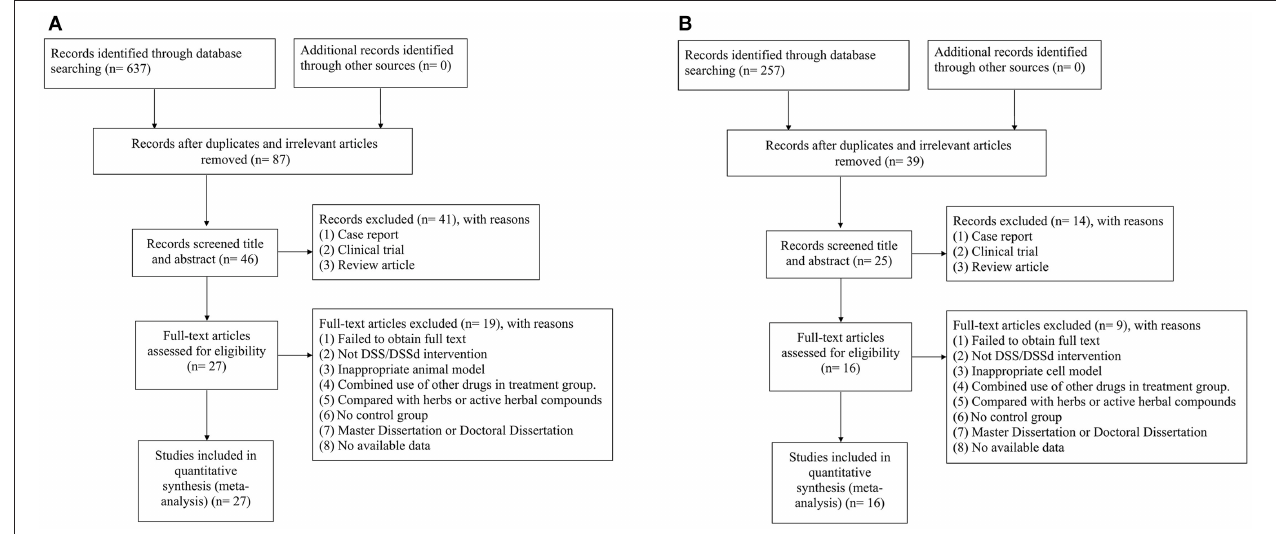
FIGURE 1 | (A) Search strategy for animal experiments: 637 potentially relevant studies were identified, after removal of duplicates and the application of inclusion and exclusion criteria, 27 studies were included in the meta-analysis; (B) search strategy for cell experiments: 257 potentially relevant studies were identified, after removal of duplicates and the application of inclusion and exclusion criteria, 16 studies were included in the meta-analysis.